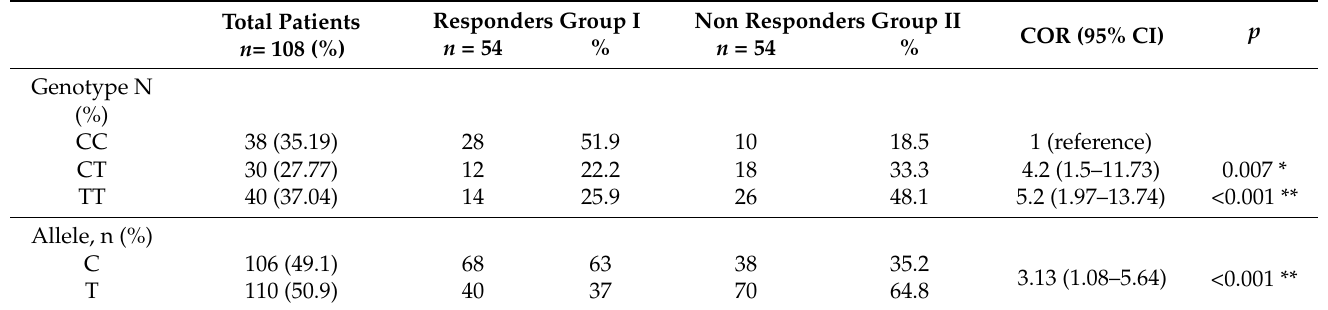
Table 3. Genotype and allele frequencies IL28B (rs12979860) distribution through the responder and non-responder